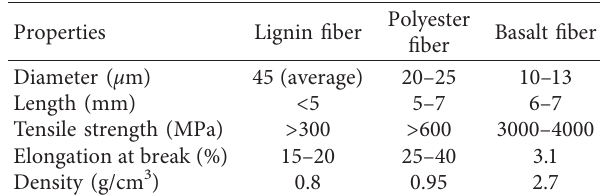
Figure 1: Images of different types of fiber: (a) lignin fiber, (b) basalt fiber, and (c) polyester fiber. Table 4: Technical properties of different types of